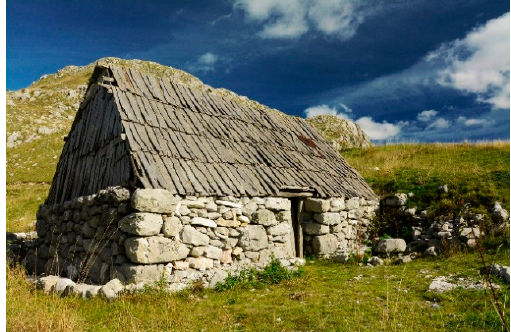
Figure 21. Glada built of the stones from the immediate vicinity - Momonjevo, the lower katun, photo: I. Lakovi ć .